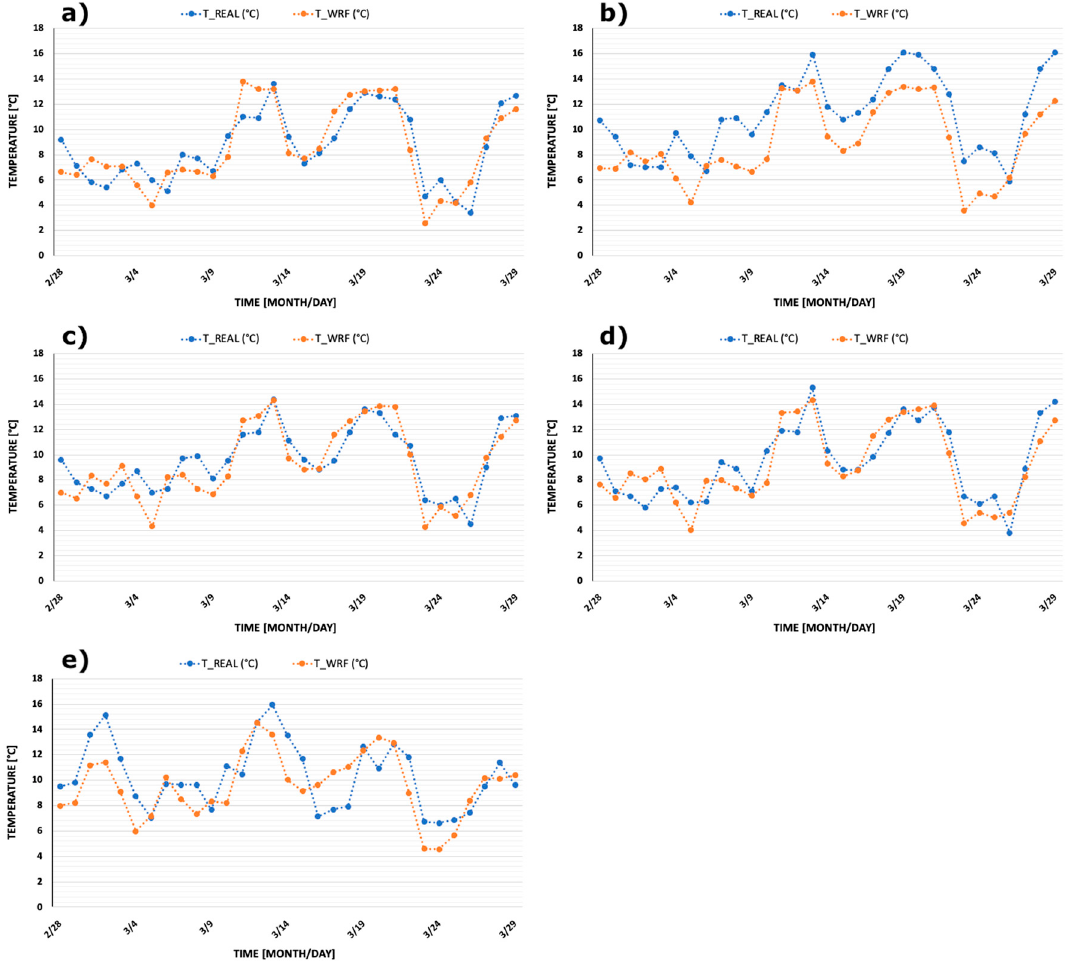
Figure 2. Comparisons between daily mean temperatures measured at selected province monitoring stations (‘T_REAL’) and the related average over each province obtained through the Weather Research and Forecasting (WRF) model (‘T_WRF’). Provinces are: ( a ) Bergamo, ( b ) Brescia, ( c ) Mantova, ( d ) Cremona, and ( e ) Pesaro Urbino.